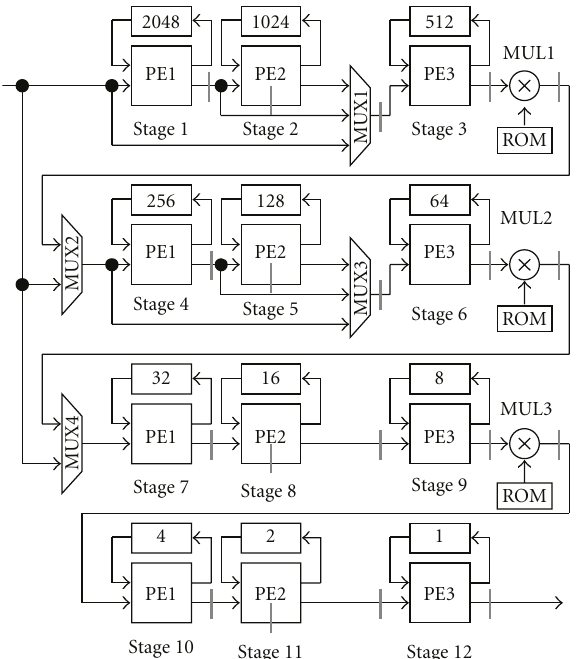
Figure 3: Architecture of the generated SISO variable-length radix-2 3 FFT